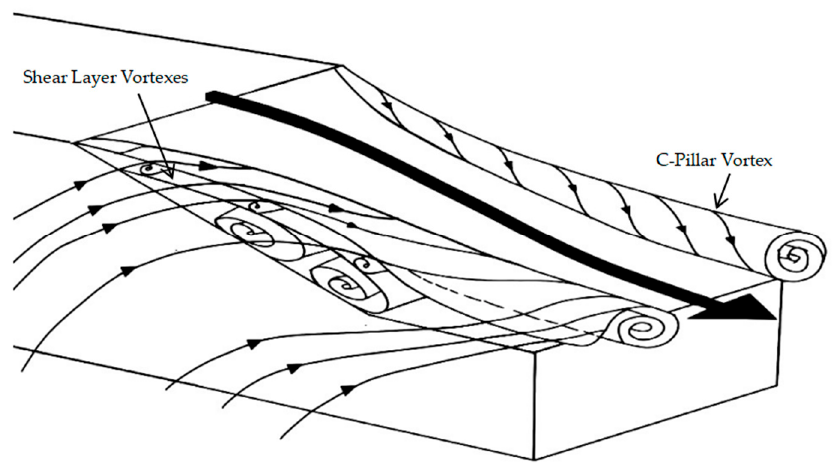
Figure 1. Proposed flow topology over the rear of notch-back vehicles. Adapted from [3].